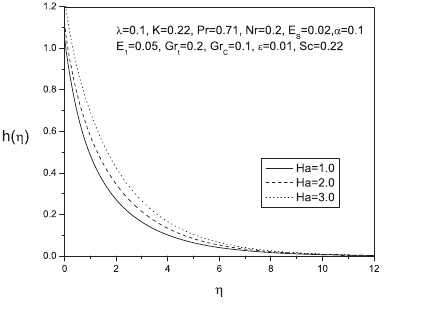
Figure 9. Variation of temperature profiles with η for different values of λ